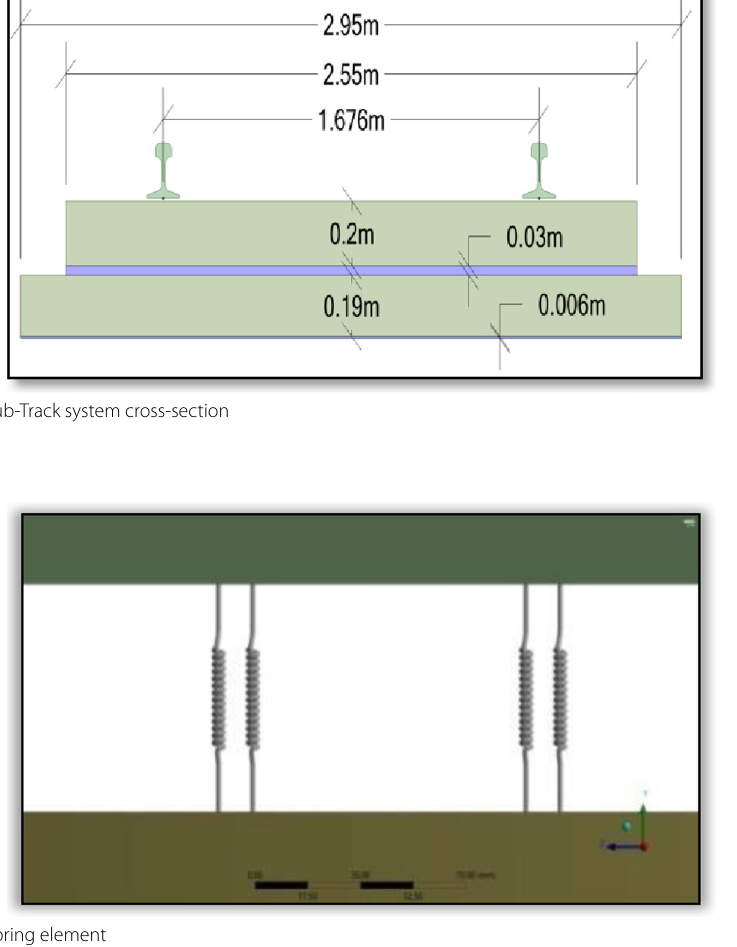
Fig. 7 Spring element